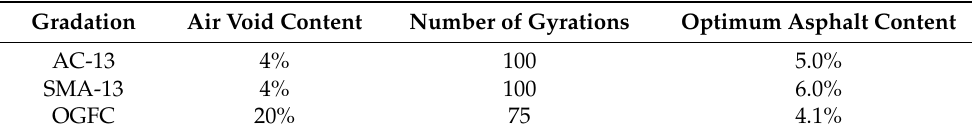
Figure 1. Gradation curves of 3 kinds of asphalt mixtures. Table 1. The experimental data required for the sample.